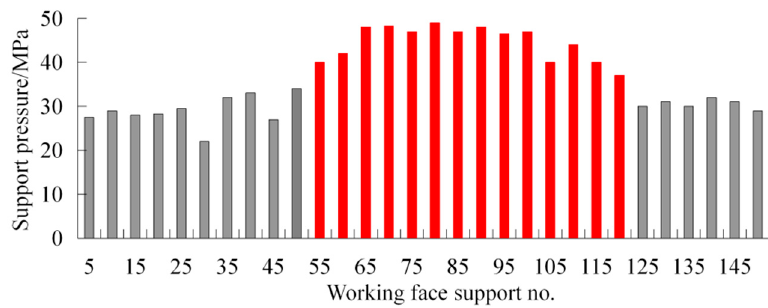
Figure 3. Distribution of support resistance during first weighting.